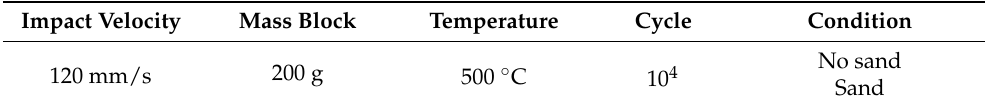
Table 1. Detailed parameters of impact